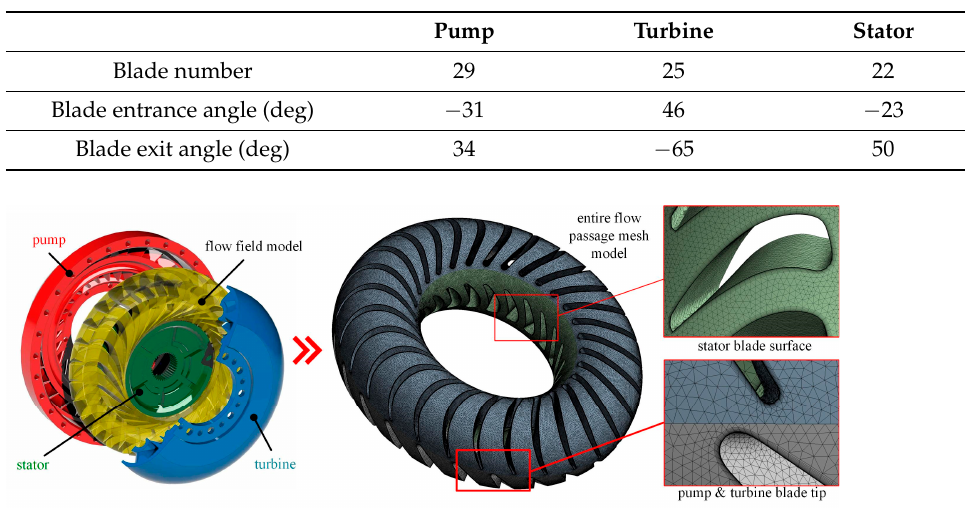
Figure 2. Geometry and mesh model of torque